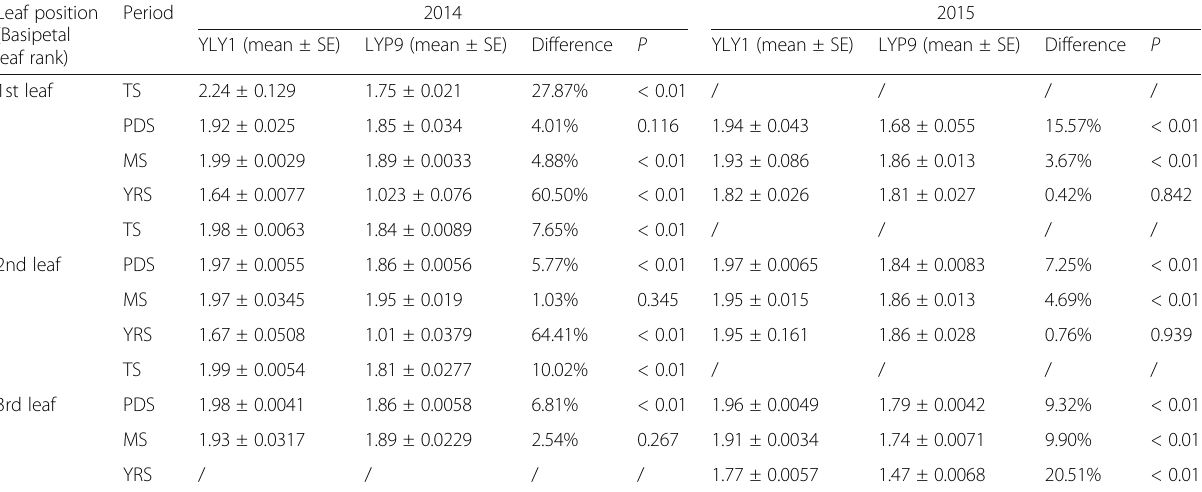
Table 1 Chlorophyll Concentration (FW, mg (cid:129) g − 1 ) in canopy leaves with10 replicates were measured with SPAD-502(Minolta Camera Co. Ltd., Japan) at different growth stages, then use the SPAD vs actual chlorophyll content calibration for cv. YLY1 and LYP9 respectively in 2014 and 2015.TS means tillering stage, PDS means panicle differentiation stage, MS means Milk stage of grain filling,